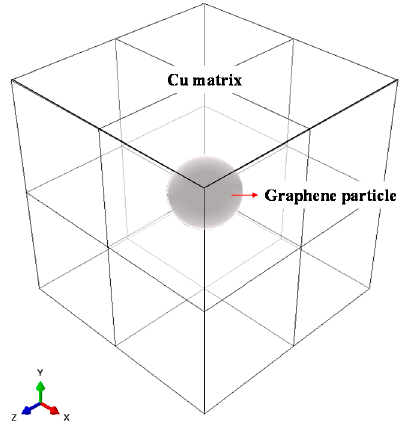
Figure 2. RVE model for graphene/Cu composites.